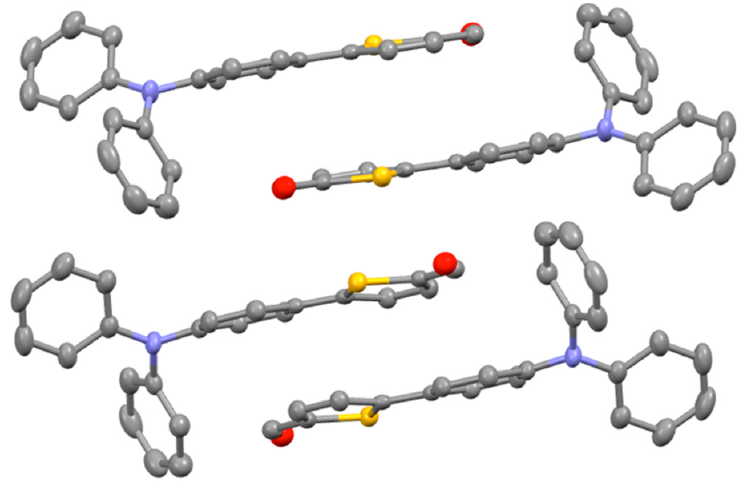
Figure 2. Packing of 1 along the b axis.